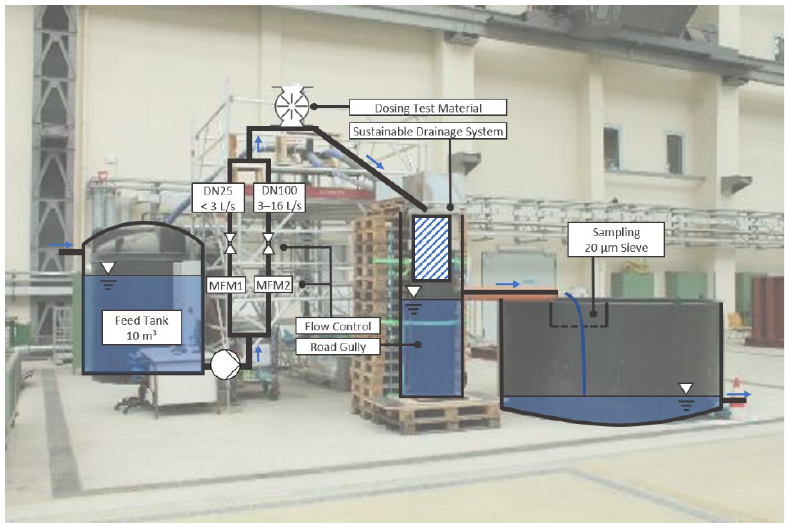
Figure 1. Test stand in the Department of Urban Water Management at the TU of Berlin according to DIBt requirements.